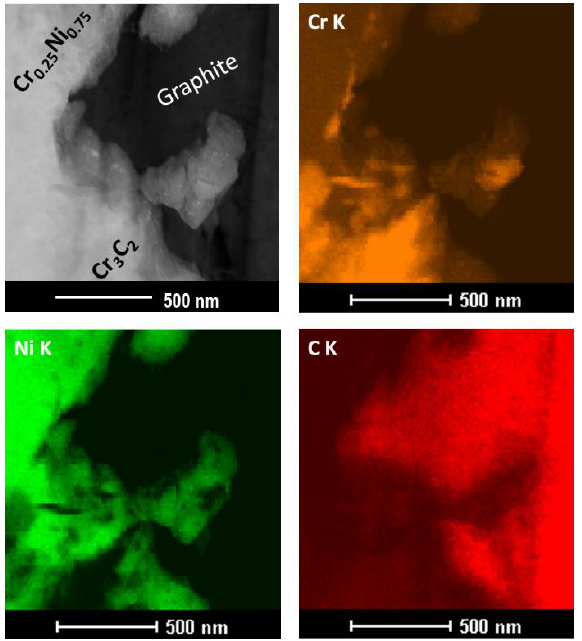
Figure 8. Cross-section and map of elements distribution (Cr, Ni, C) of coating deposited with parameters set 1 (TEM).